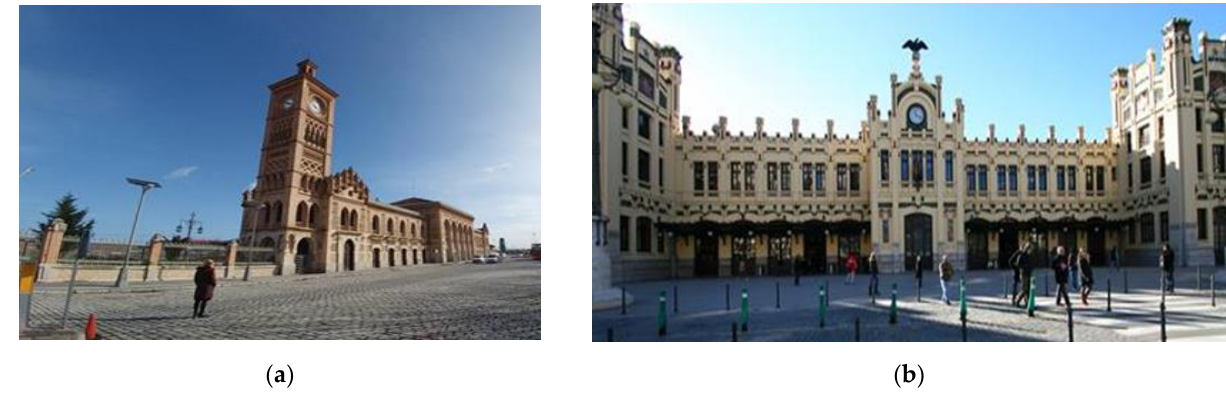
Figure 9. ( a ) Príncipe-Pío railway station. ( b ) Canfranc International railway station. Own archive (2020).